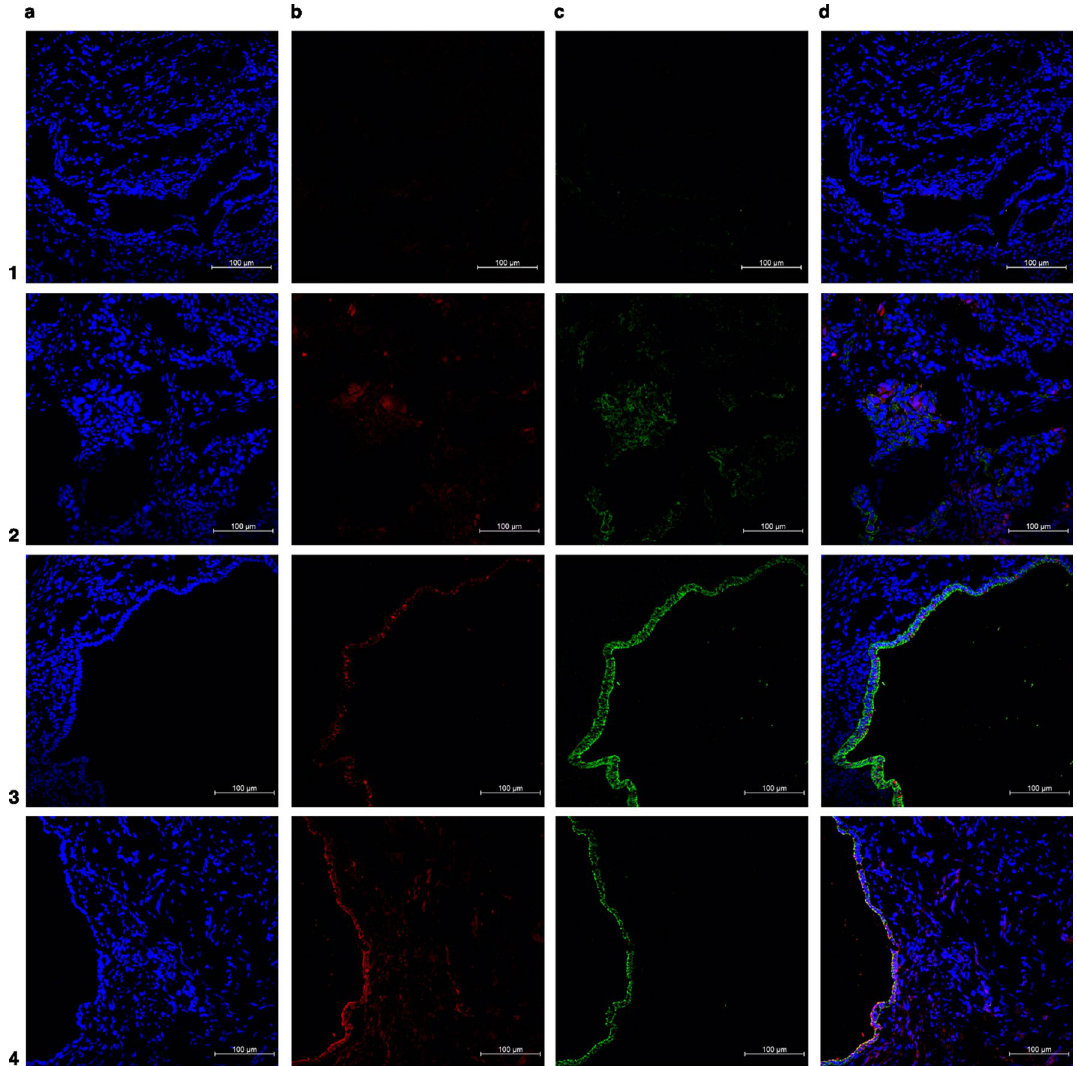
Figure 4. Representative immunofluorescence co-stained images of deep infiltrating endometriosis. ( a ) In blue: DAPI ( b ) in red: senescent associated biomarkers (p16 or lamin b1) ( c ) in green: anti-E-cadherin antibody (epithelial glandular cells) ( d ) merged. Number 1 row represents negative control (deep infiltrative endometriotic lesion), number 2 row represents positive control (endometrial cancer or random ovary), number 3 row represents deep infiltrating lesion labeled with p16, and number 4 row represents deep infiltrating lesion labeled with lamin b1. ×20